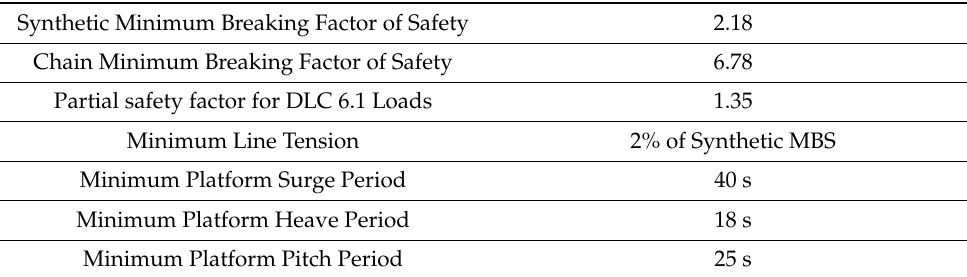
Table 4. Mooring System Design